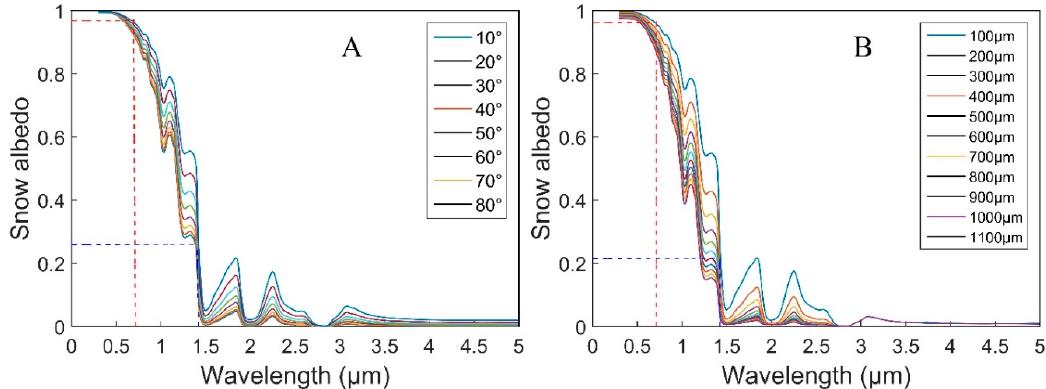
Figure A1. ( A ) Influence of different solar zenith angles on the snow spectral albedo (snow grain size = 200 μ m). ( B ) Influence of different effective snow grain sizes on snow spectral albedo (solar zenith angle = 60°). The red line is the auxiliary line at a wavelength of 0.7 μ m, and the blue line is the auxiliary line at a wavelength of 1.4 μ m.